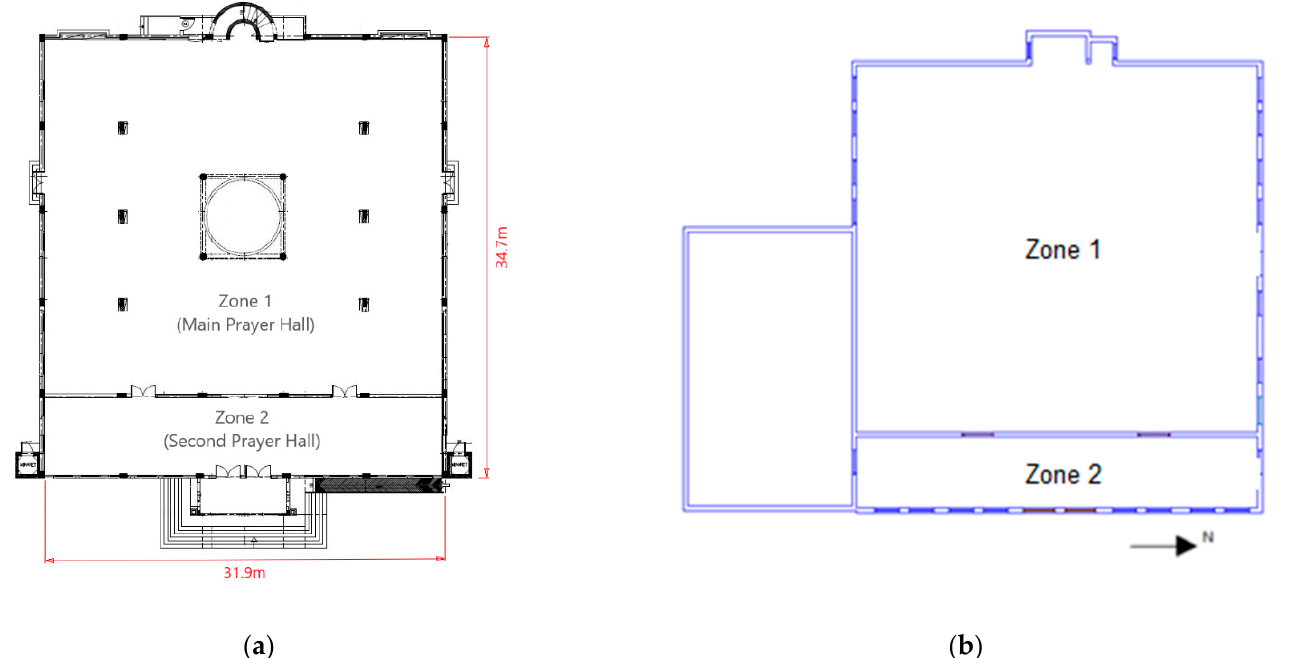
Figure 4. ( a ) Ground floor plan of Hudhayfah Mosque; ( b ) ground floor plan of Hudhayfah Mosque as shown in Tas software showing the two zones.